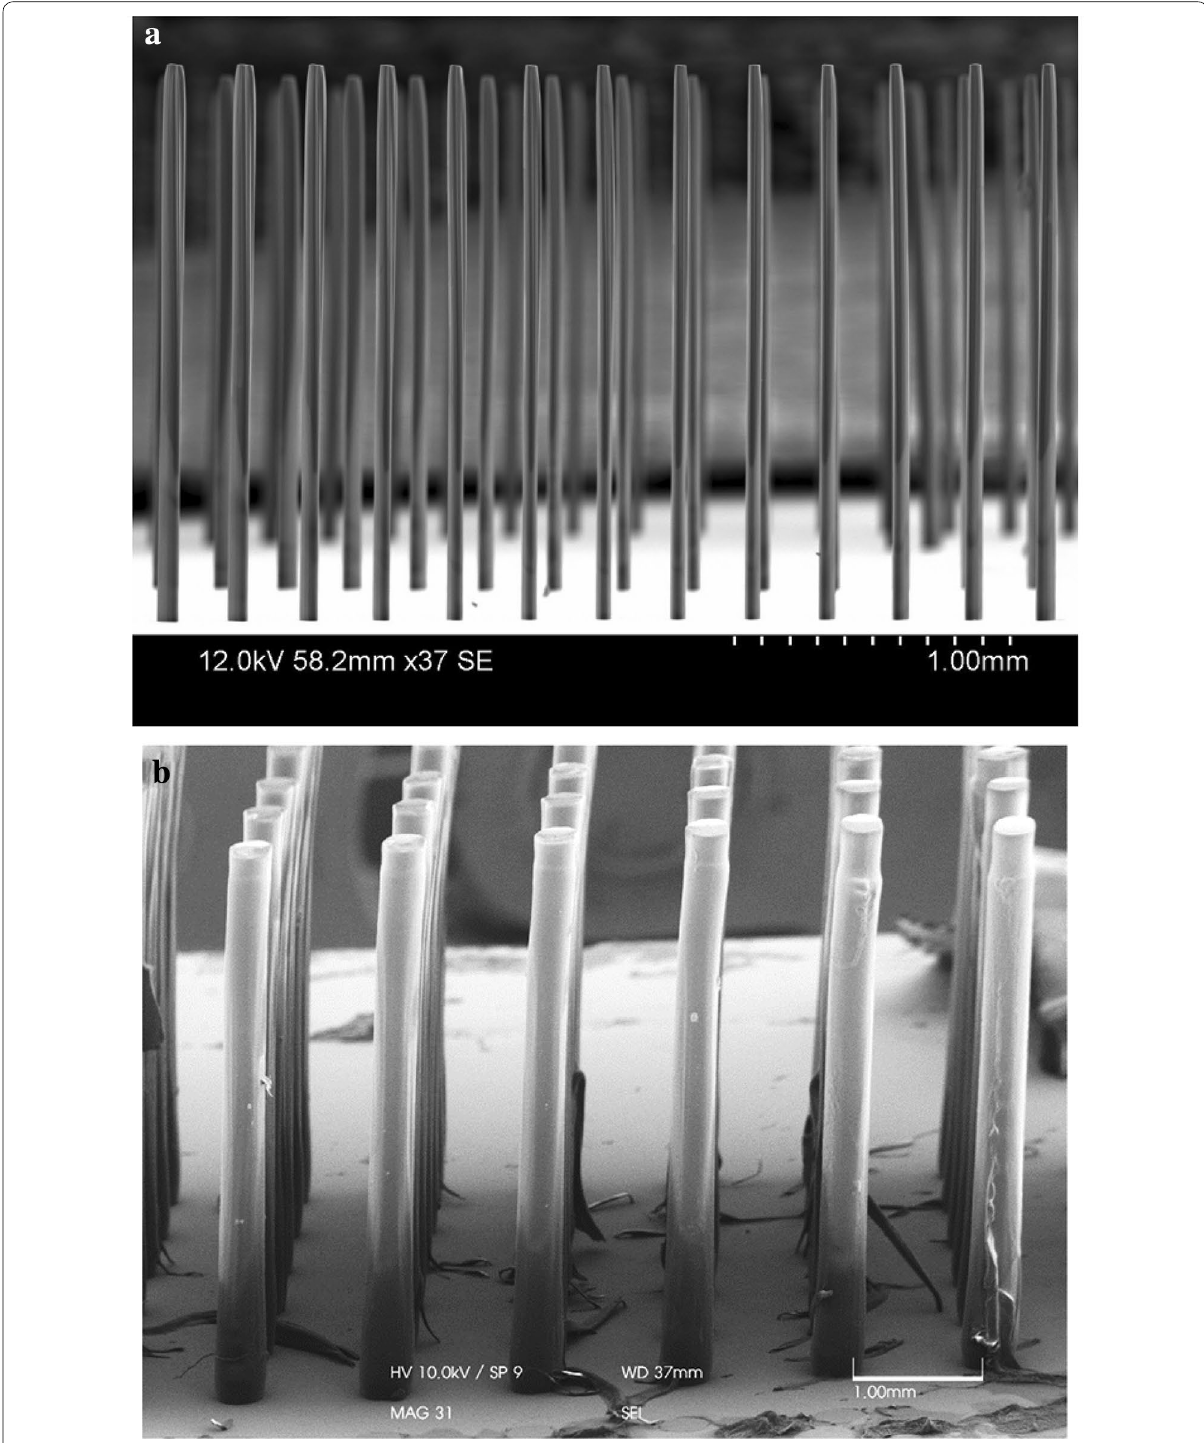
Fig. 6 Array structures of 2000-µm-tall and 4000-µm-tall microtowers; an acrylic filter applied during the UV exposure. Smooth, straight side wall was